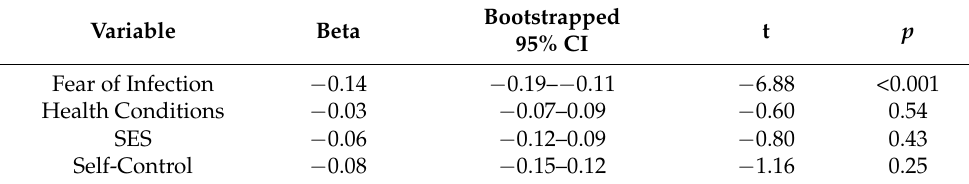
Table 1. Model 1: Direct Effects